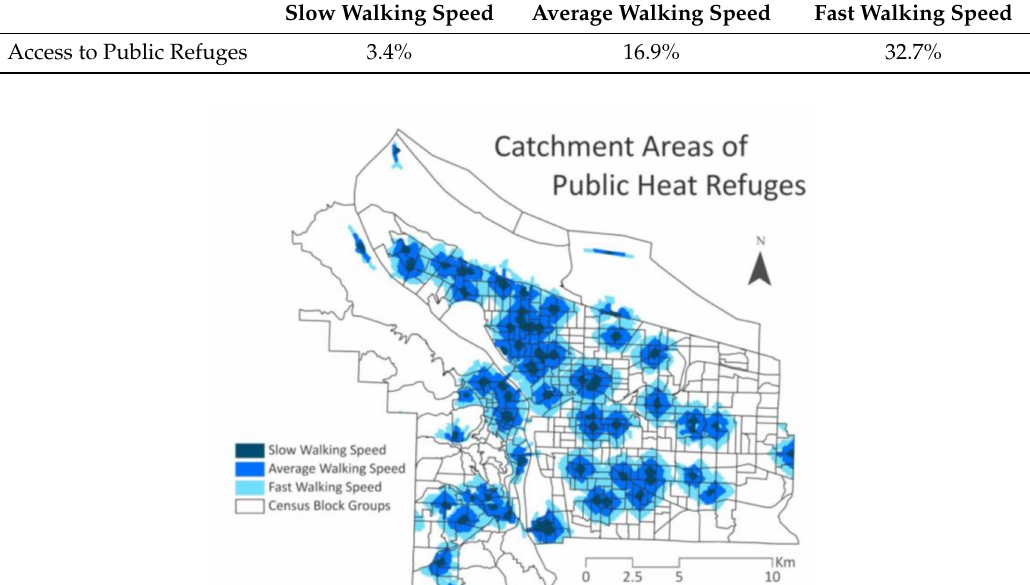
Table 3. Percentage of the city having access to one or more public heat refuges (cooling centers).